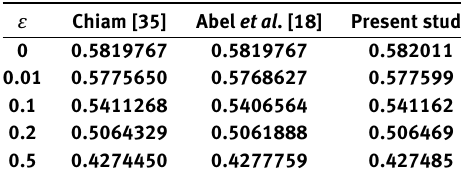
Figure 4: Horizontal velocity profiles Table 2: Values of − θ ′ (0) for various values of ε